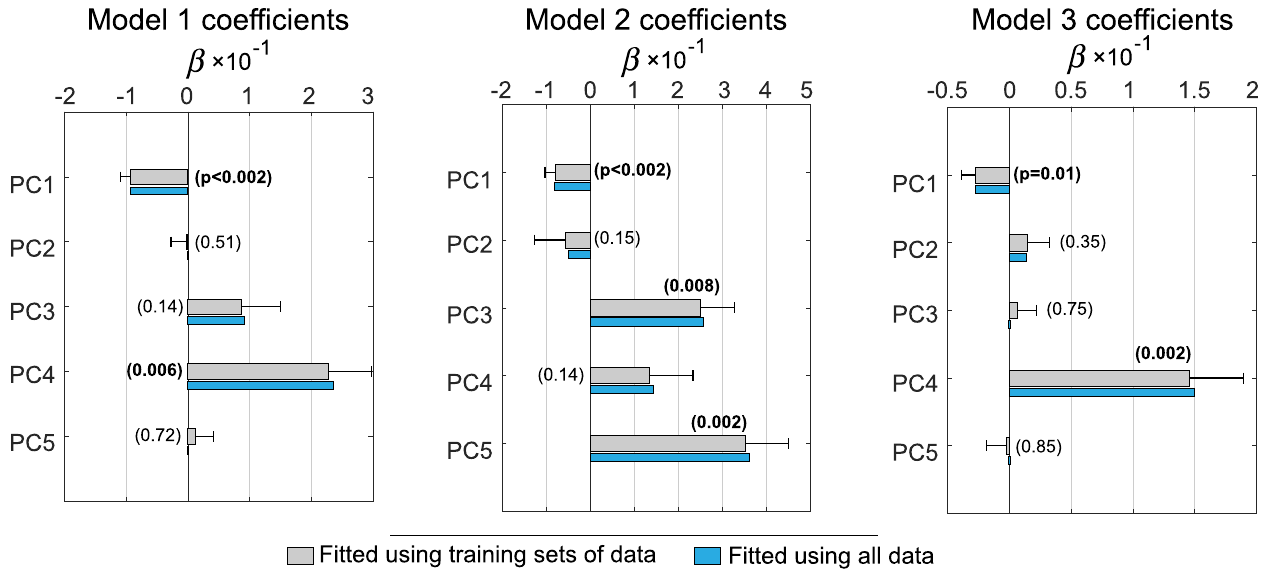
Fig 7. The mean values, standard deviations, and p-values of the fit coefficients β j . The means and standard deviations (error bars) were obtained from 500 training sets. The coefficients that were fitted on all available data are plotted for comparison. Values of p < 0.05 are highlighted with bold font.